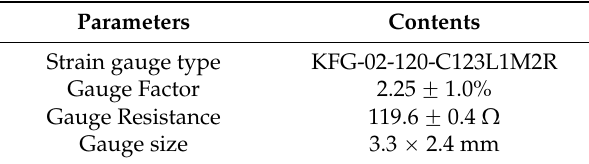
Figure 11. Torque sensors. ( a ) 3-beam torque sensor; ( b ) TSHS. Table 3. Specification of the strain gauge.